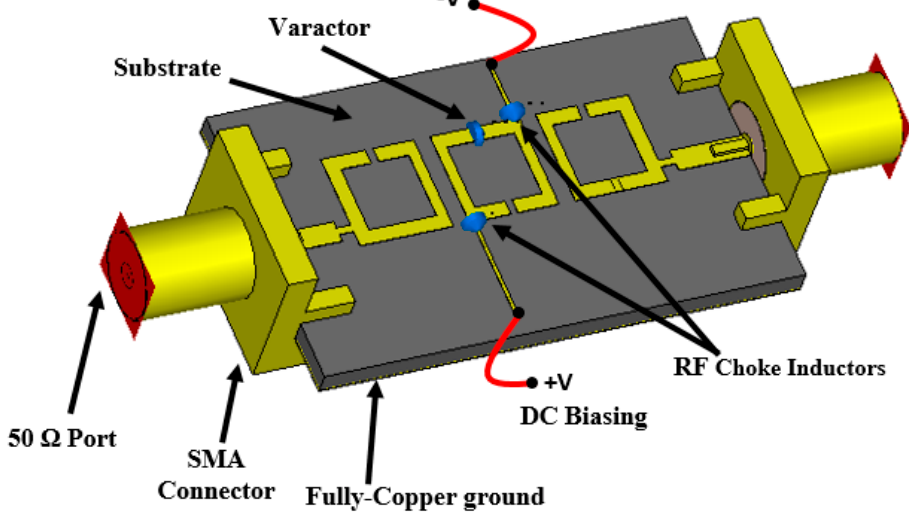
Figure 11. 3D Layout of the tuneable microstrip filter [61].